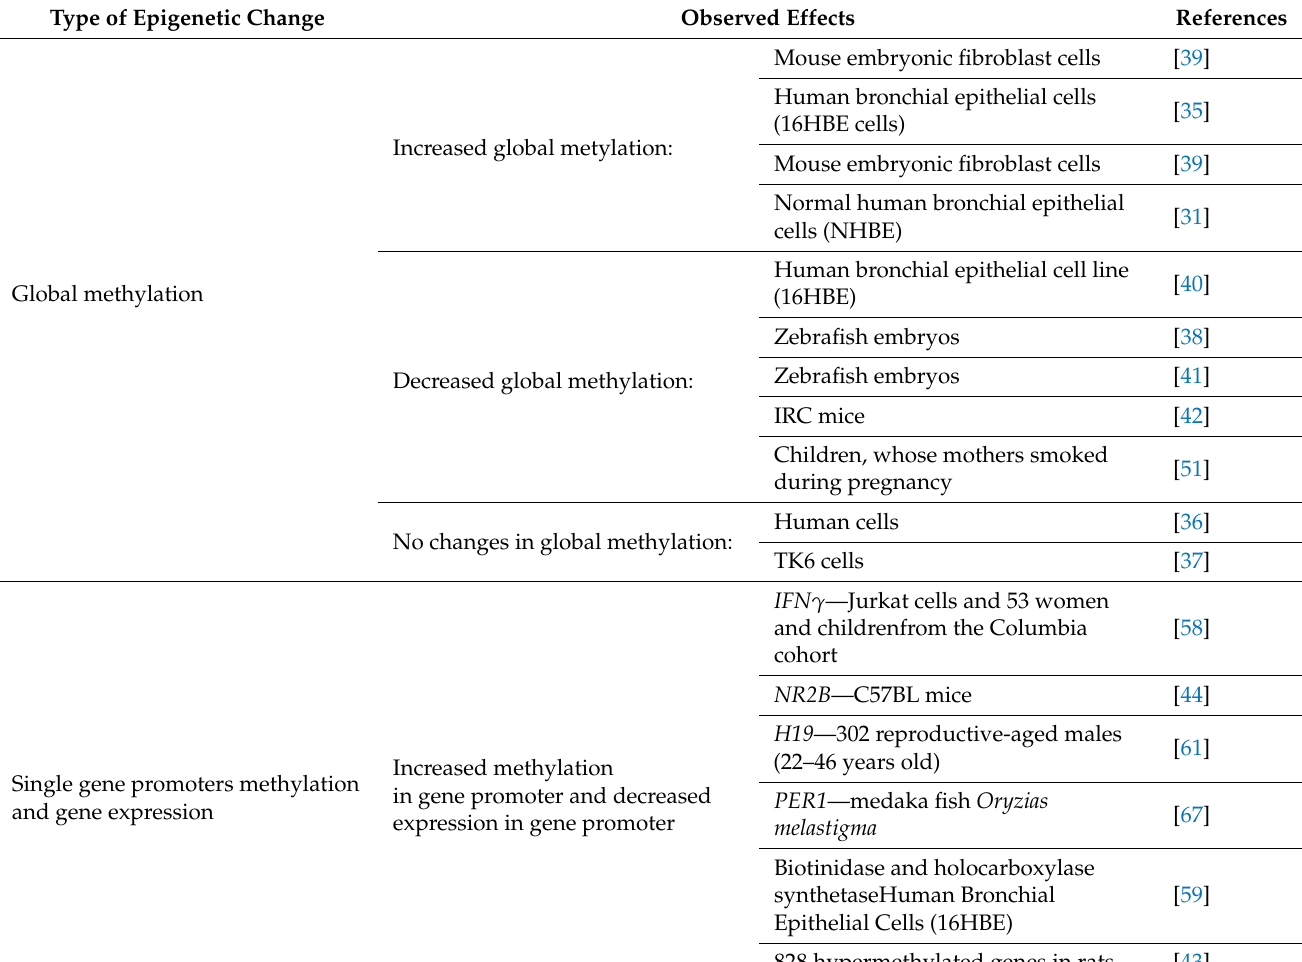
Table 1. Potential epigenetic effects induced by BaP and its metabolite BPDE. Type of Epigenetic Change Observed